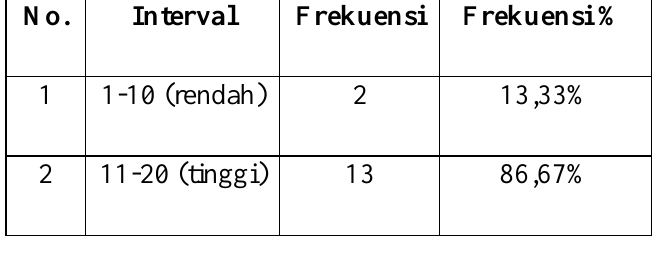
Tabel 2. Data Interval Hasil Observasi Motivasi Belajar